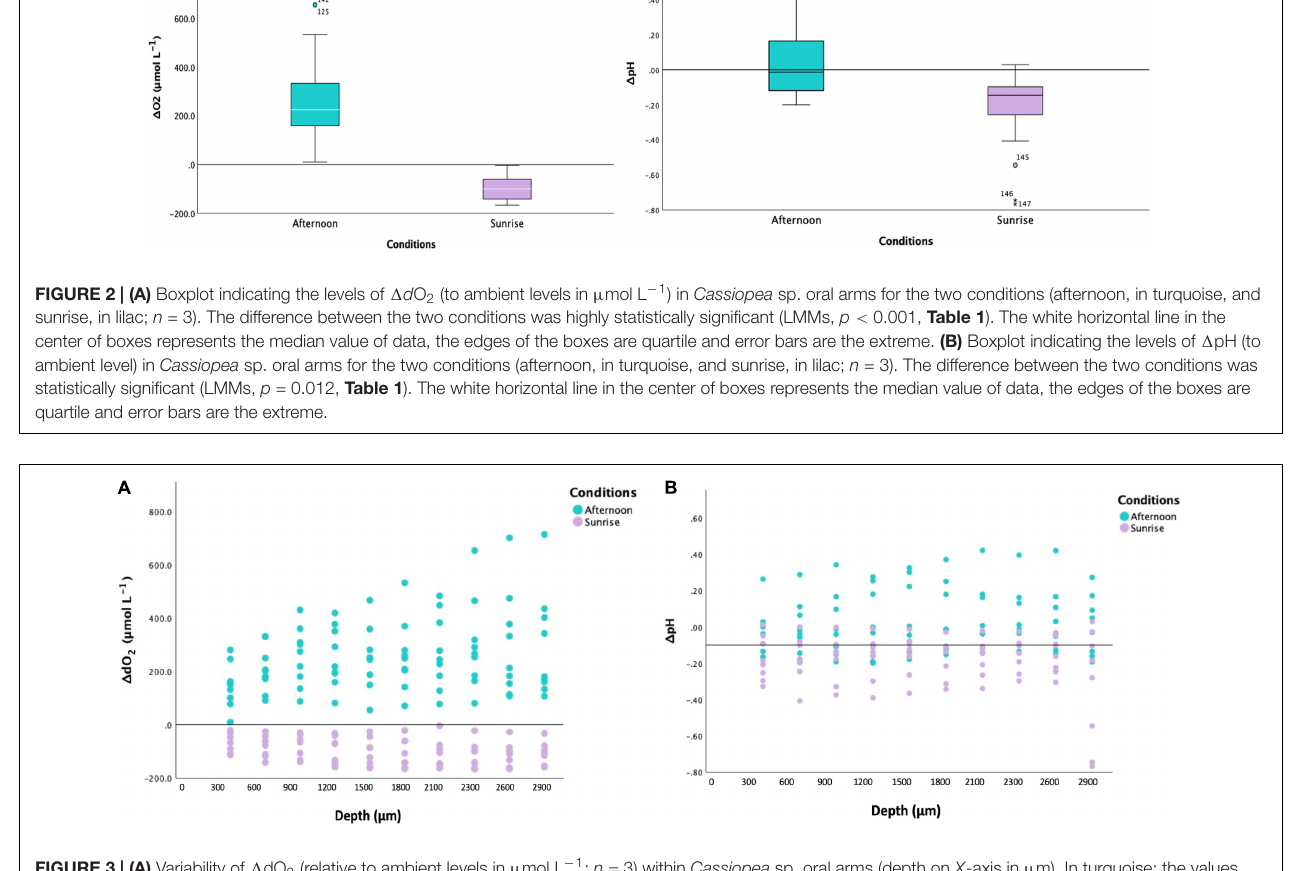
FIGURE 3 | (A) Variability of (cid:49) dO 2 (relative to ambient levels in µ mol L − 1 ; n = 3) within Cassiopea sp. oral arms (depth on X -axis in µ m). In turquoise: the values obtained from specimens collected during the afternoon. In lilac: the values obtained from specimens collected at sunrise. (B) Variability of (cid:49) pH (relative to ambient levels in µ mol L − 1 ; n = 3) within Cassiopea sp. oral arms (depth on X -axis in µ m). In turquoise: the values obtained from specimens collected during the afternoon. In lilac: the values obtained from specimens collected at